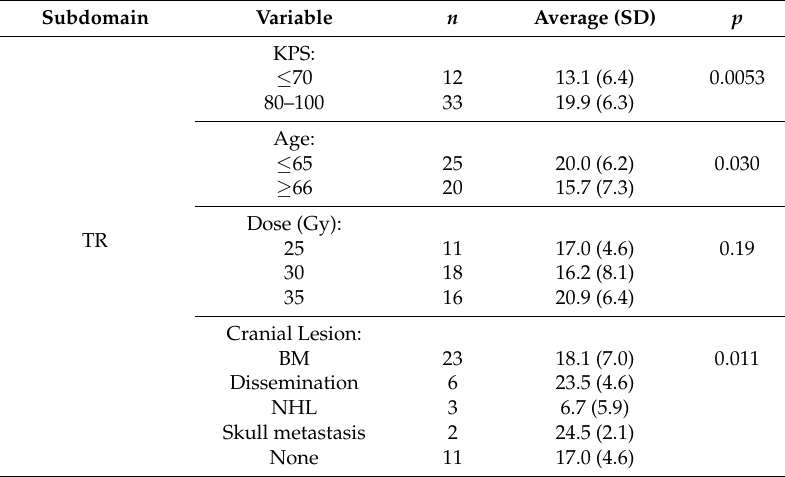
Table 3. Baseline HVLT-R scores and associated clinical